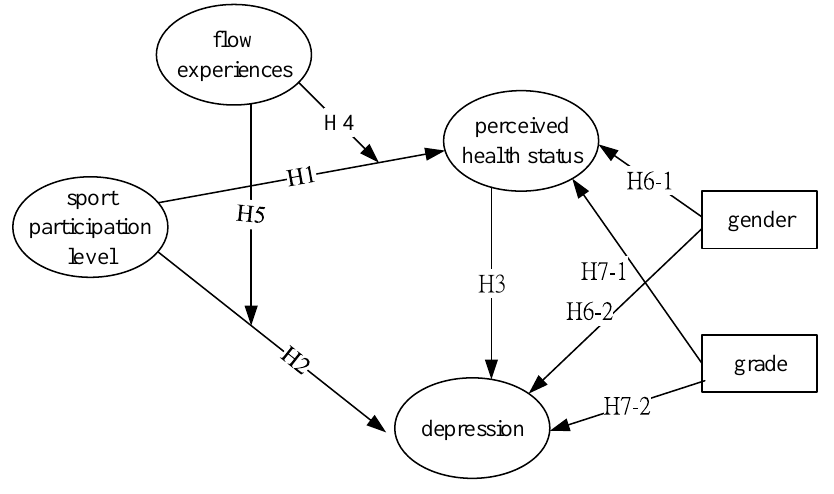
Figure 1. Research hypotheses framework.